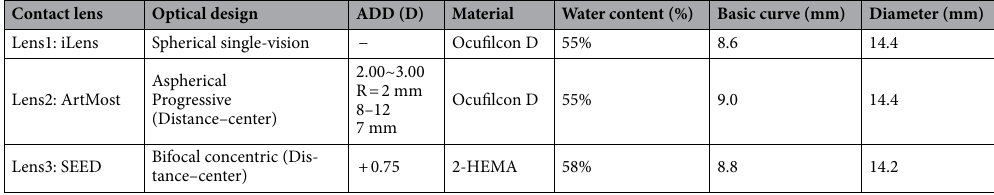
Table 1. Contact lens design and specification